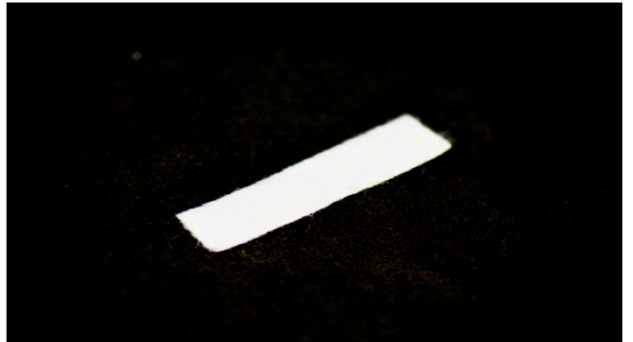
Figure 3. Flat Kaltostat drain.